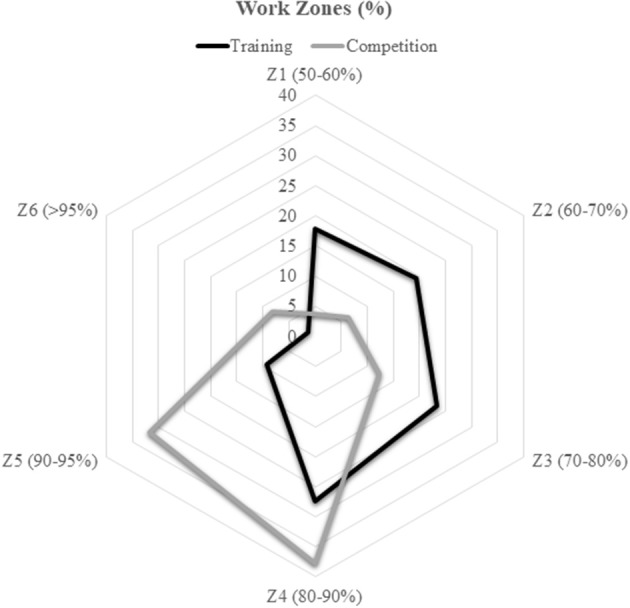
Work zones by game situation.